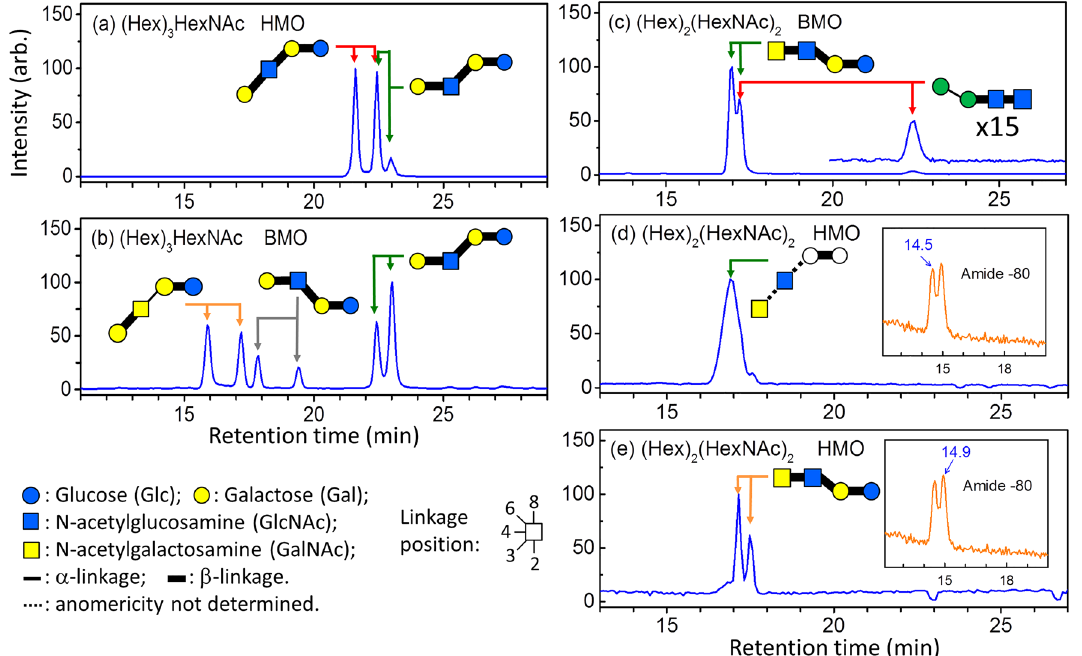
Figure 6. PGC chromatograms of tetrasaccharides ( a, b ) ion m/z 730 [sodium adducts of (Hex) 3 HexNAc]; ( c– e ) ion m/z 771 [sodium adducts of (Hex) 2 (HexNAc) 2 ] for human milk oligosaccharides (HMO) and bovine milk oligosaccharides (BMO). The inserts in ( d, e ) are the amide-80 chromatograms of ion m/z 771, in which eluents at the retention time of 14.5 and 14.9 min were collected separately and injected into a PGC column to obtain the chromatograms shown in ( d , e ), respectively. The fraction collected from the amide-80 column was chosen such that all oligosaccharides found in this study are shown in a single chromatogram for compact display. The relative intensity in this chromatogram does not represent the relative abundance of these oligosaccharides in milk. The oligosaccharide structure for each peak in chromatograms was determined using LODES/MS n . Some of tetrasaccharide structures were crosschecked using the chromatogram retention time of synthesized oligosaccharides. Details of the structural determination using LODES/MS n are described in Supplementary